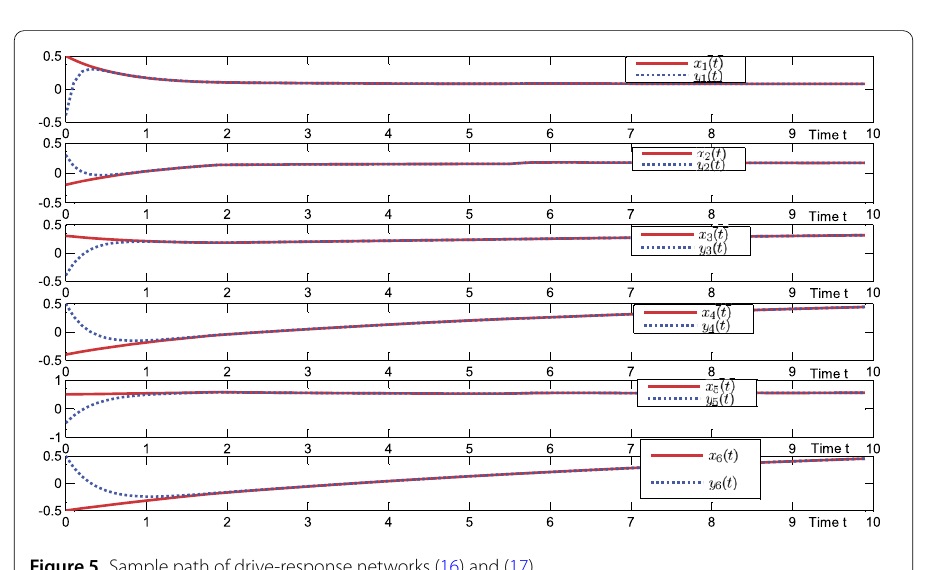
Figure 5 Sample path of drive-response networks (16) and